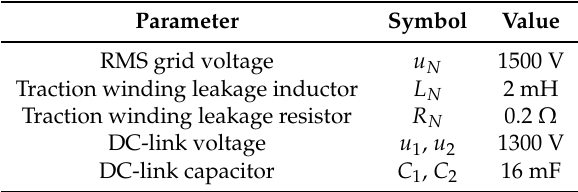
Table 4. Parameters of converter.